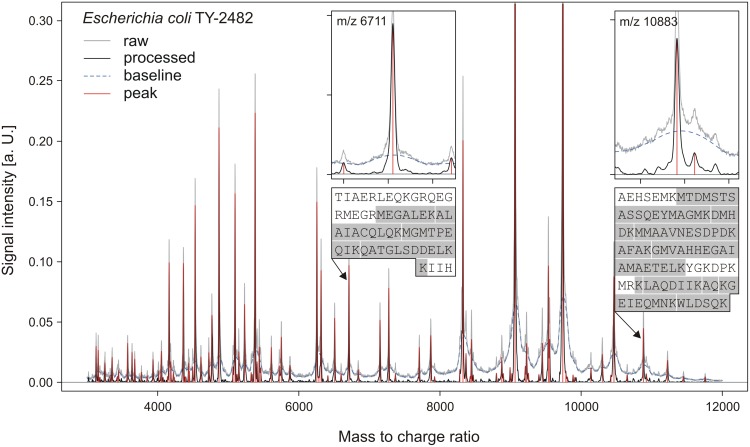
MALDI-TOF mass spectrum of E. coli outbreak isolate TY-2482.Representative whole cell MALDI-TOF mass spectrum of the Shiga-Toxigenic E. coli outbreak isolate TY-2482 acquired after formic acid extraction. Inlays show enlarged views of outbreak strain specific marker peaks and the amino acid sequence of the corresponding proteins. Peptides identified by LC-MS/MS are indicated by a gray background. The tick mark interval in the enlarged peak views is set to 100.